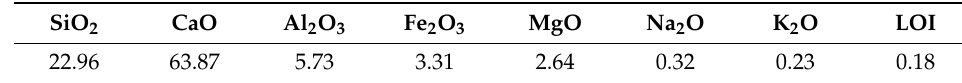
Table 2. Chemical composition of OPC/%.